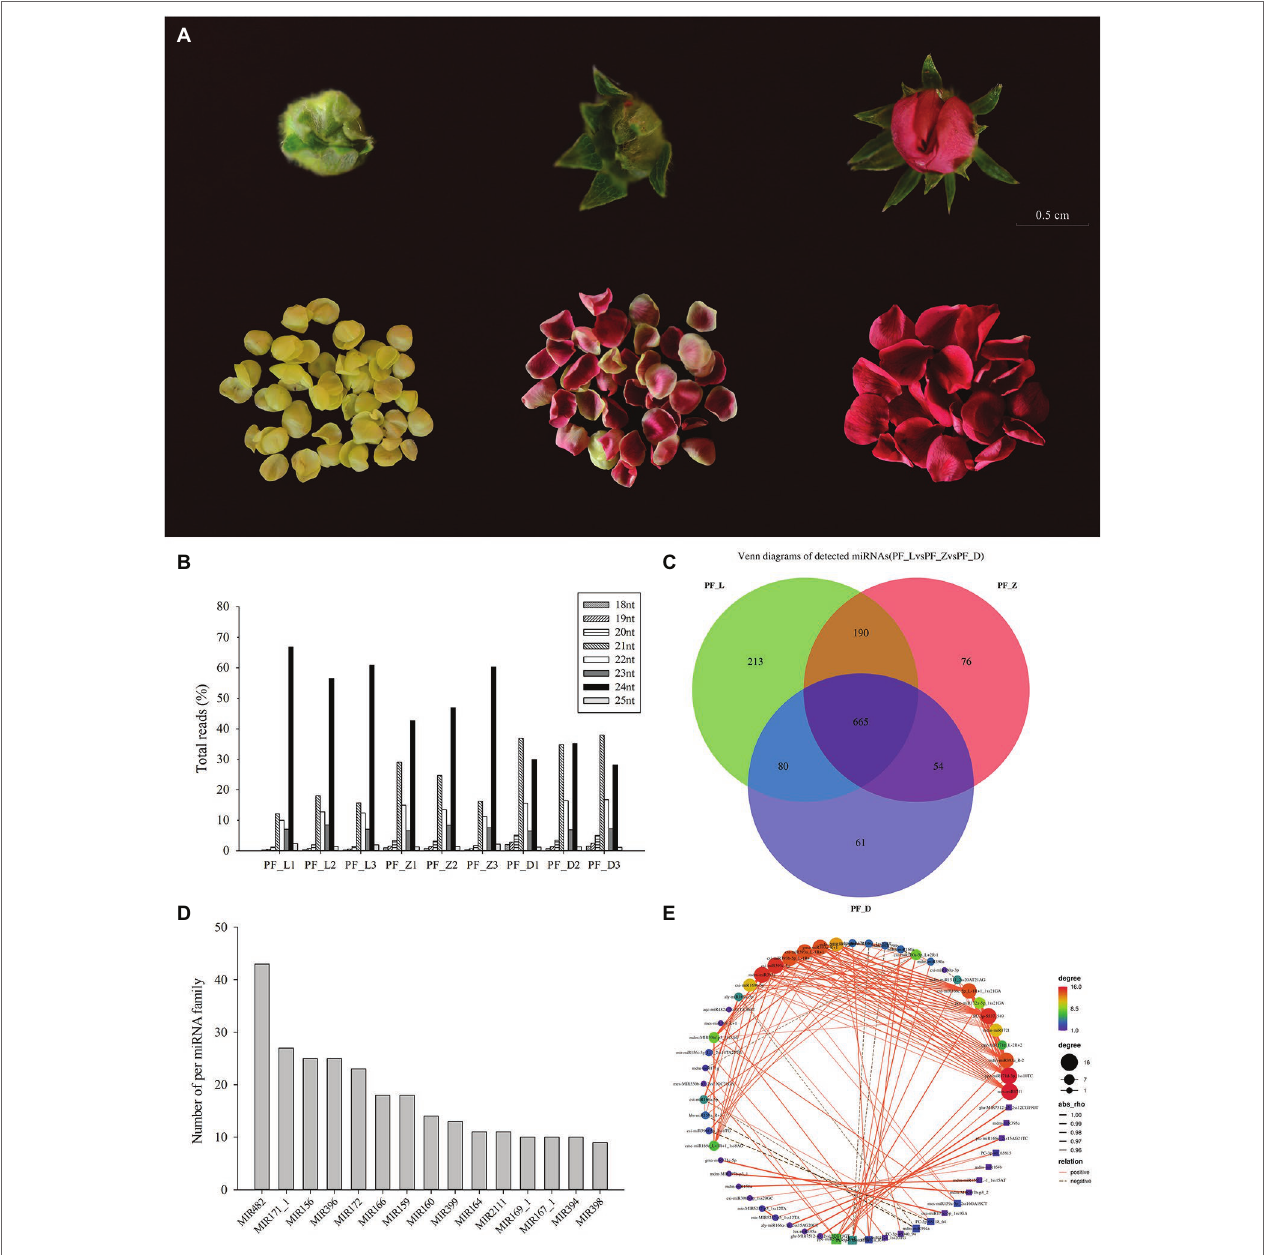
FIGURE 1 | sRNAome data obtained from the different petal developmental stages of pink-flowered strawberry. (A) The petal developmental stages of pink- flowered strawberry cultivar Sijihong. (B) Length of sRNAs in nine libraries. (C) Venn diagram showing the number of differentially expressed microRNAs (miRNAs) during the different petal developmental stages. (D) Top 15 known miRNA families. (E) The correlation network constructed for 412 miRNAs. The solid lines show a positive correlation, while the dotted lines show a negative correlation. L, young bud stage; Z beginning coloration stage; and D, big bud